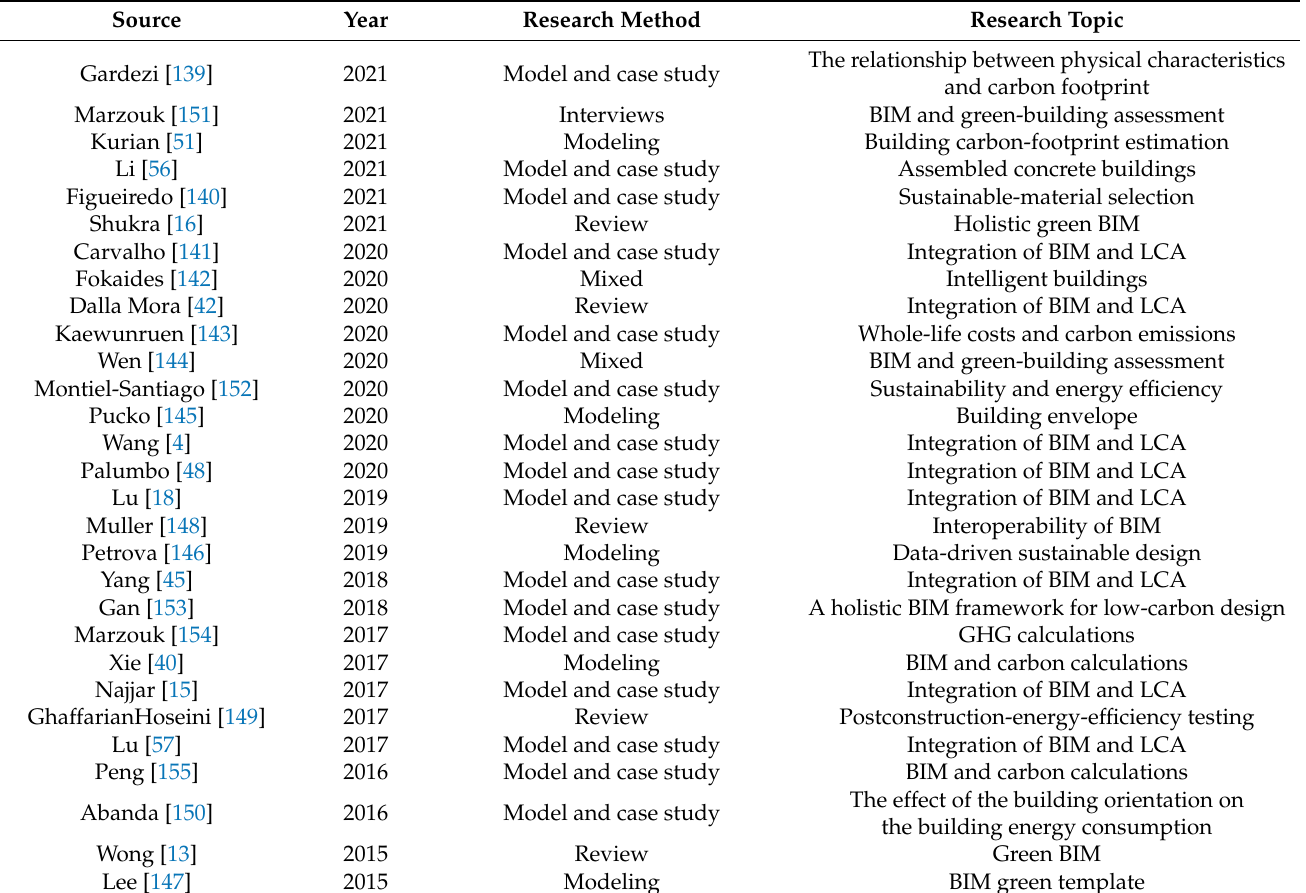
Table 6. The role of BIM across whole lifecycle stages in terms of carbon emissions (generated by the